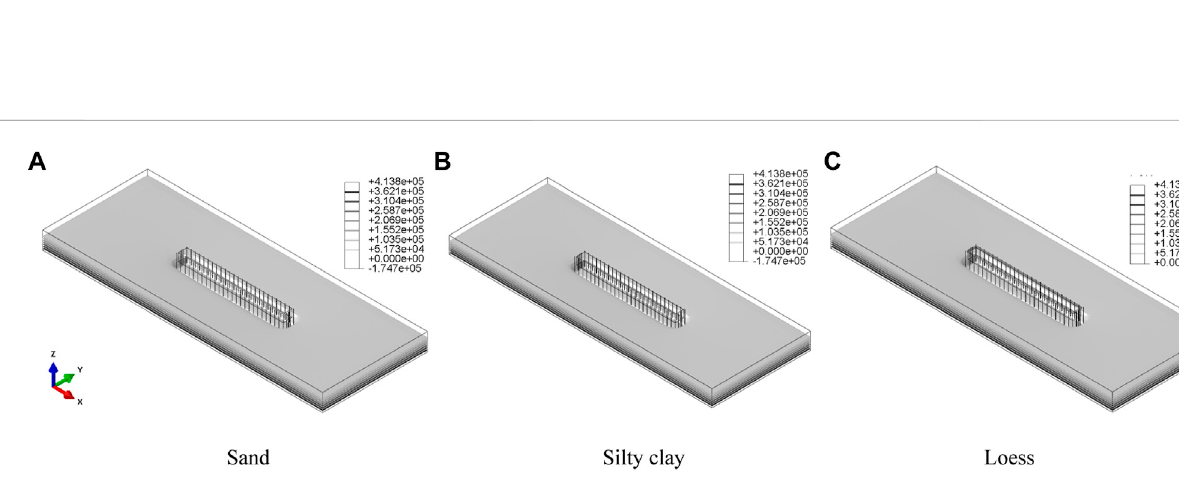
FIGURE 5 Isosurface contour of pore pressure after pit excavation (Unit: Pa) (A) Sand (B) Silty clay (C) Loess.